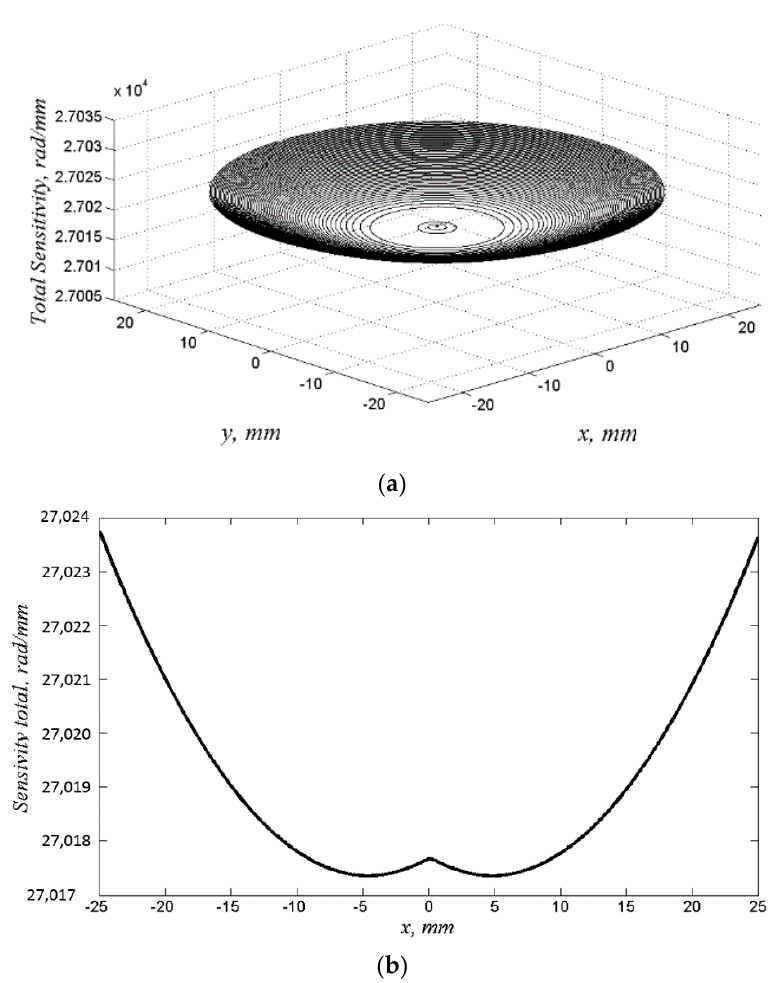
Figure 4. ( a ) Total sensitivity of the system, ( b ) Total sensitivity in plane y = 0 .